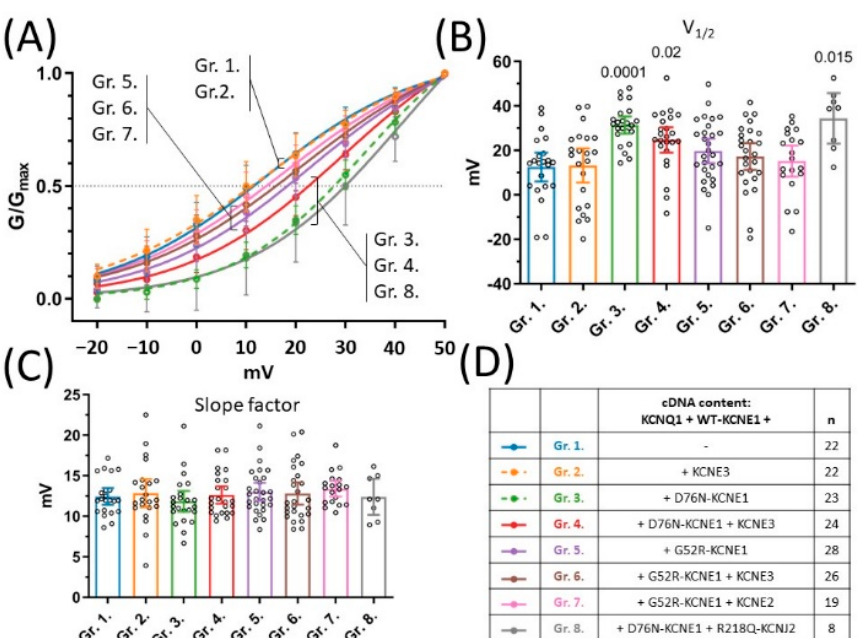
Figure 4. Voltage-dependence of steady-state activation. Steady-state activation curves as represented by mean normalized conductance ±95% CI values and non-linear curve fits ( A ). Mean ±95% CI half-maximal activation voltages ( B ) and mean ±95% CI slope factors ( C ) were statistically compared by one-way ANOVA followed by Holm–Sidak’s post-hoc tests. Multiplicity-adjusted p values are shown where difference between group means was considered significant ( p < 0.05). cDNA